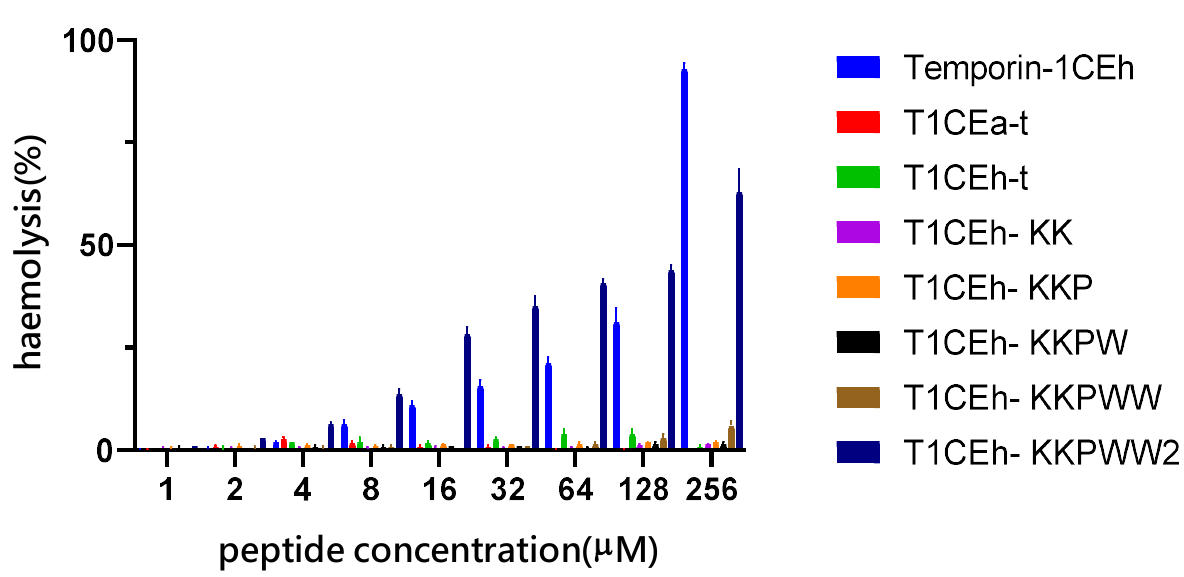
Figure 4. The haemolytic activity of Temporin-1CEh and its analogues at gradient changed concen- trations. Positive control and negative control are 1% Triton X-100 and PBS, respectively. Haemolysis rates of positive control and negative controls were 100% and 0%, respectively. Error bars represent the SEM of three replicates.